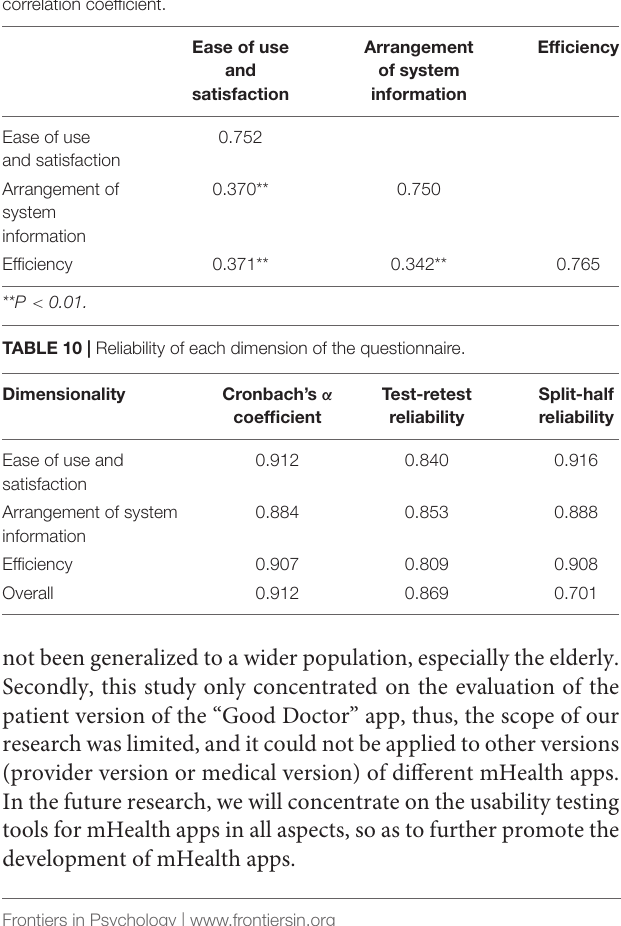
TABLE 9 | The results of the discriminant validity analysis using the Pearson’s correlation coefficient.